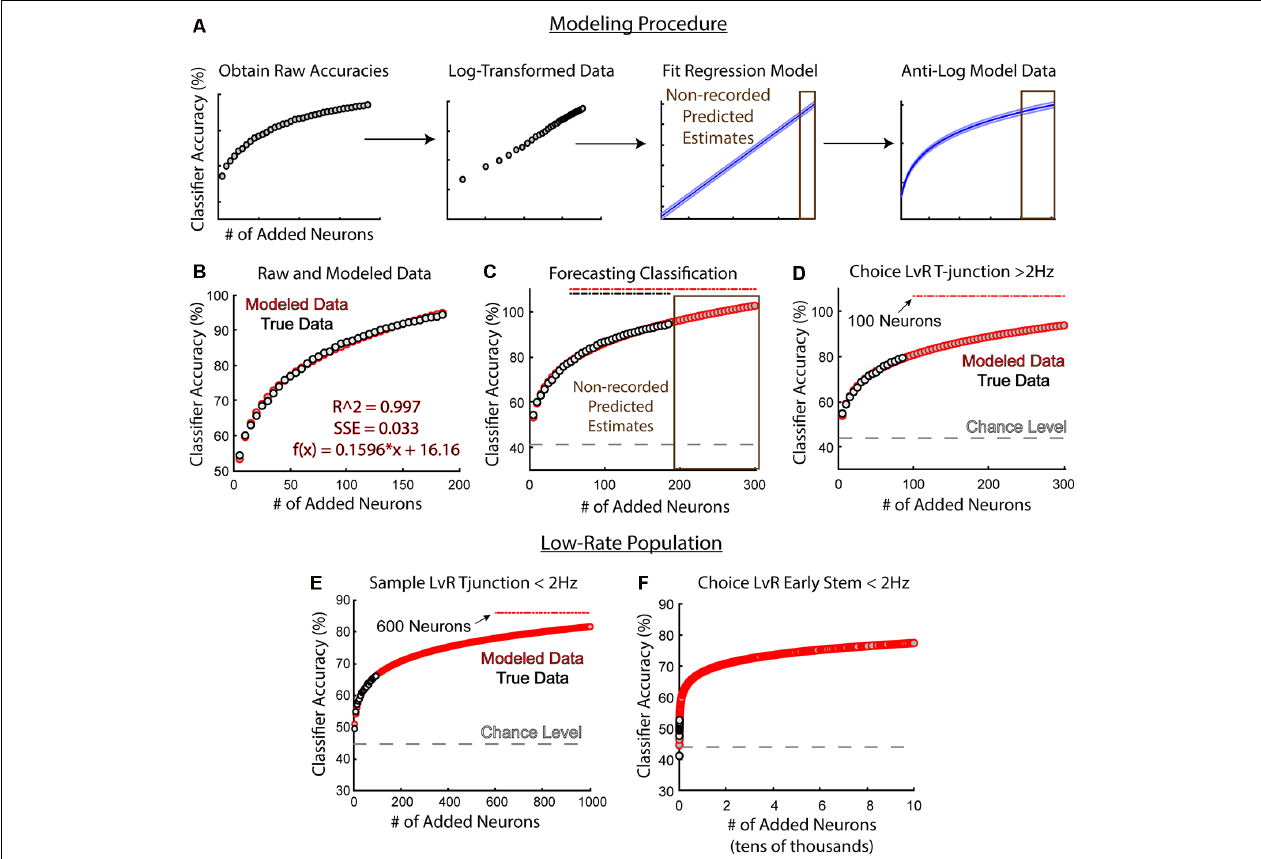
FIGURE 8 | Modeling future classification accuracies reveal that low-rate neurons may weakly dissociate distinct trajectories at T-junction. (A) Classification accuracies and their corresponding sample-size (number of added neurons) were log-transformed, fit with a linear regression model, then converted back to classification accuracies via anti-log. Once the linear regression equation was obtained, we could forecast future classification accuracies (brown). Data were taken from the classification of trajectory at sample phase T-junction. (B) An example whereby the modeled estimates fit the recorded data with high accuracy (adjusted R 2 = 0.997, SSE = 0.033) along with the regression equation. Data were taken from the classification of trajectory at sample phase T-junction. Gray dots indicate the averaged classification per sample size (averaged over 5,000 random combinations of neurons), while red dots indicate modeled data. (C) A demonstration of modeled accuracies from a population size that was not obtained. Data is the same as (A) and (B) . Recorded population N = 187. Gray dashed line indicates chance level accuracy. Brown box indicates predicted data. Dashed lines above model accuracies indicate significance utilizing a z -test. (D) Notice that a sample size of 100 neurons was predicted to yield a p < 0.05 ( Z = 1.98, p = 0.047). The high-rate population did not exhibit the above-chance classification performance at T-junction ( Figure 5C ) due to the low sample size (actual sample size = 89 neurons). Compare this to Figure 7D ; notice that 25% fewer neurons were required to predict a future decision. (E) A sample size of 600 neurons was estimated to predict trajectory at the T-junction of sample phases when considering a low-rate population ( Z = 1.96, p = 0.0499 at 600 neurons). (F) Low-rate neurons do not effectively reflect future decision-making. Note the scale shown here is from 0 to 100,000 neurons and the data was taken from the second stem